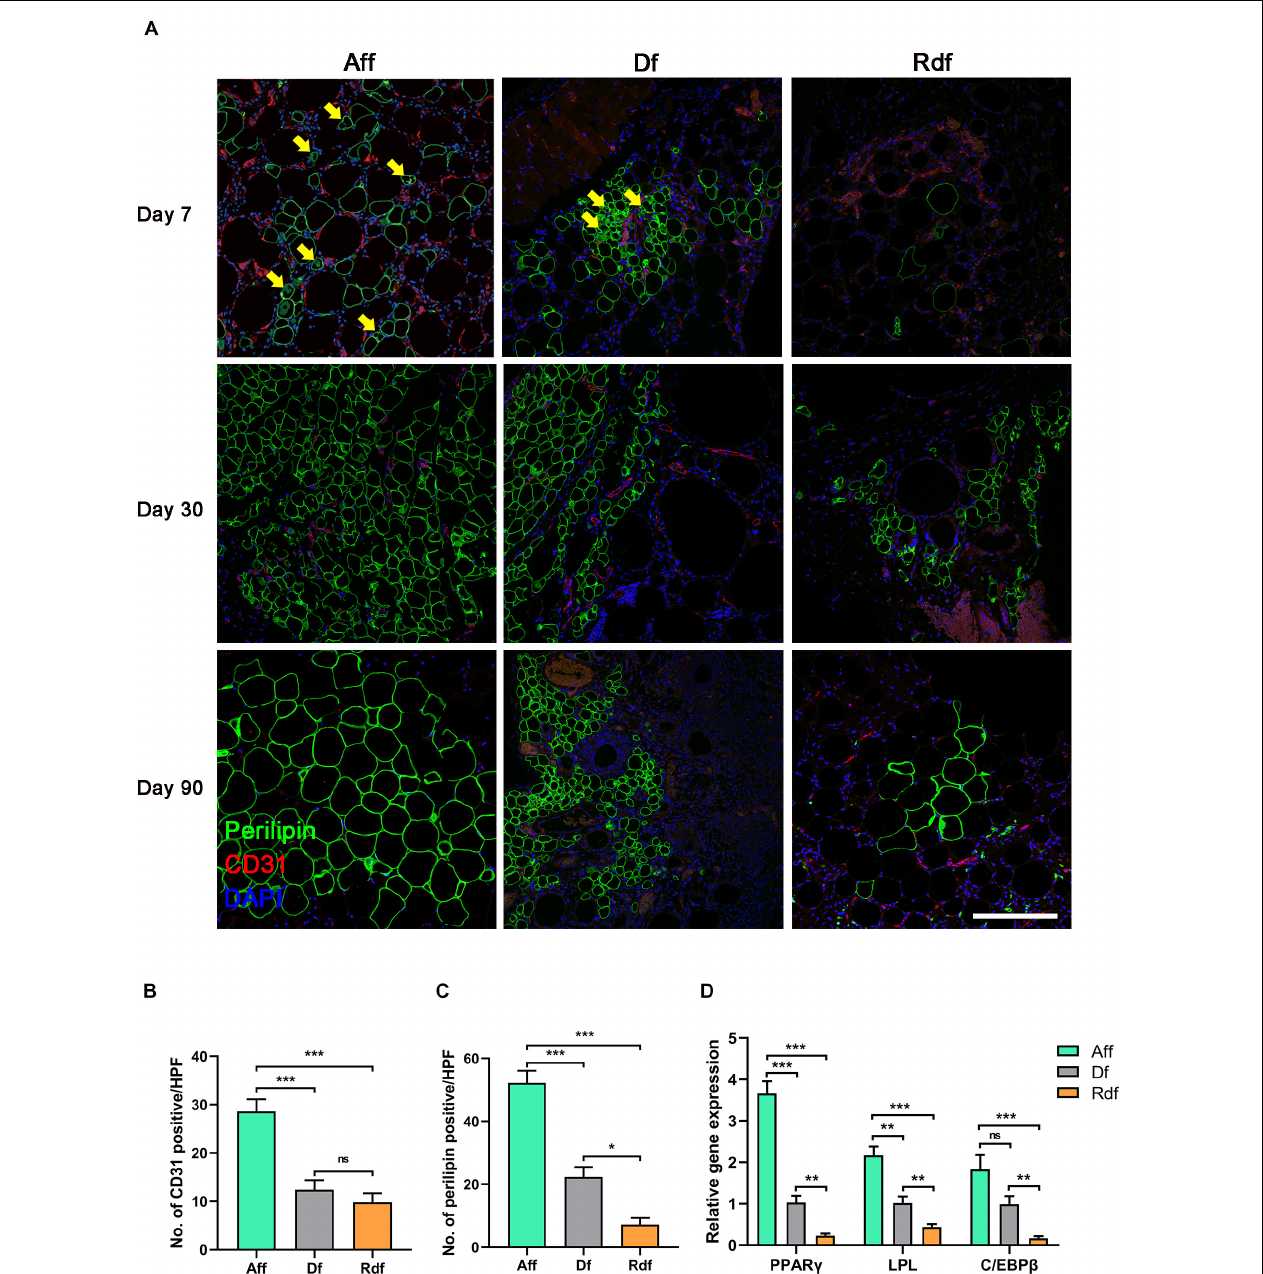
FIGURE 3 | Impaired angiogenesis and adipogenesis in Df and Rdf. (A) Representative immunofluorescence staining of perilipin (green) and CD31 (red) in Aff, Df, and Rdf grafts on post-operative day 7, 30, and 90. Early-differentiated preadipocytes (arrows) were identified in Aff and Df on day 7. Quantification of (B) CD31-positive area and (C) perilipin-positive area in grafts on post-operative day 7 per high power field (* p < 0 . 05, *** p < 0 . 001, ns = statistically non-significant). (D) Relative transcription of PPAR γ , LPL, and C/EBP β (** p < 0.01, *** p < 0.001, ns = statistically non-significant). n = 3 independent experiments with 5 samples each group. Scale bar = 100 µ